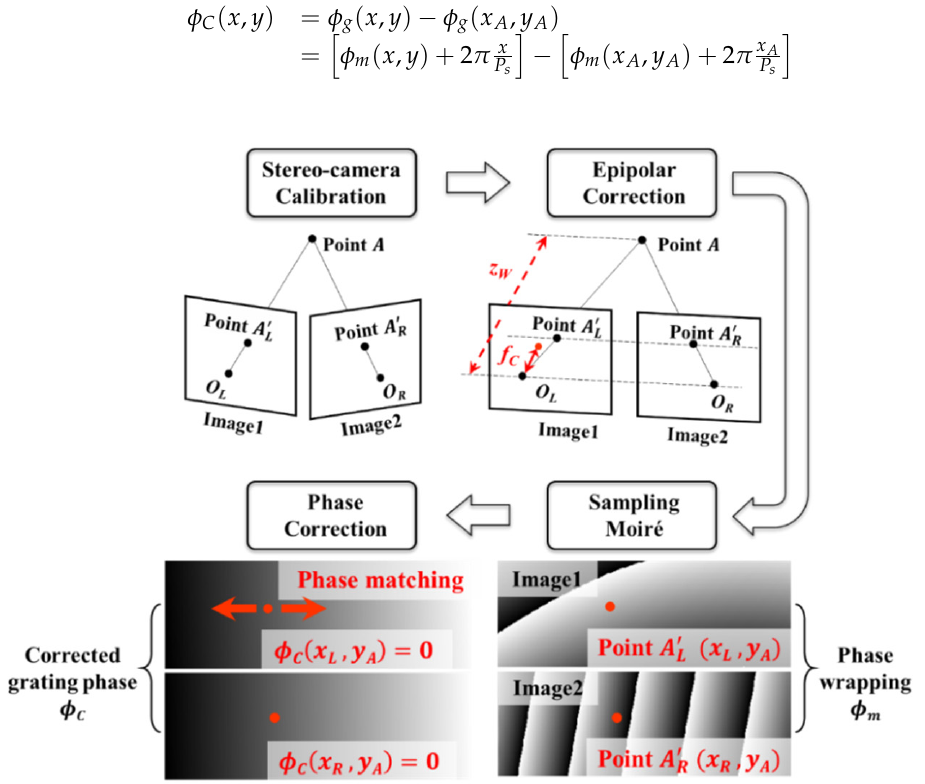
Figure 3. Phase correction process.